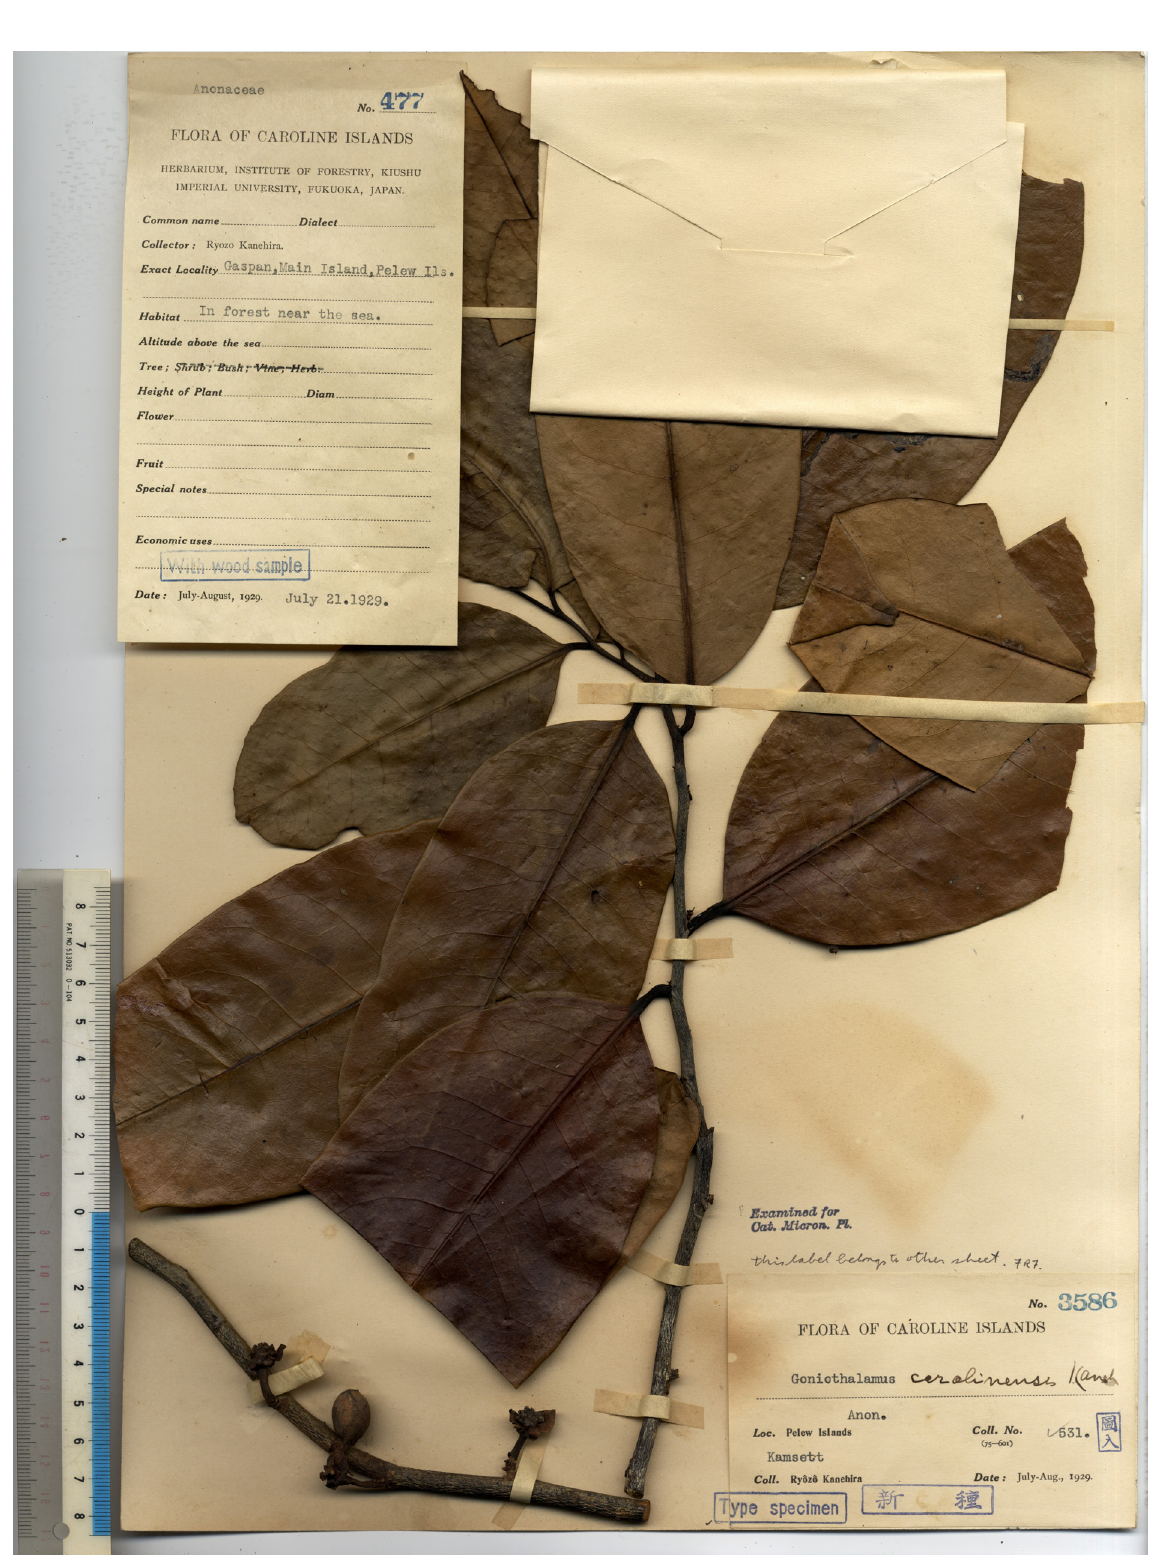
Fig. 11. Lectotype of Goniothalamus carolinensis Kaneh. Image provided by the Herbarium of Kyushu University (FU),